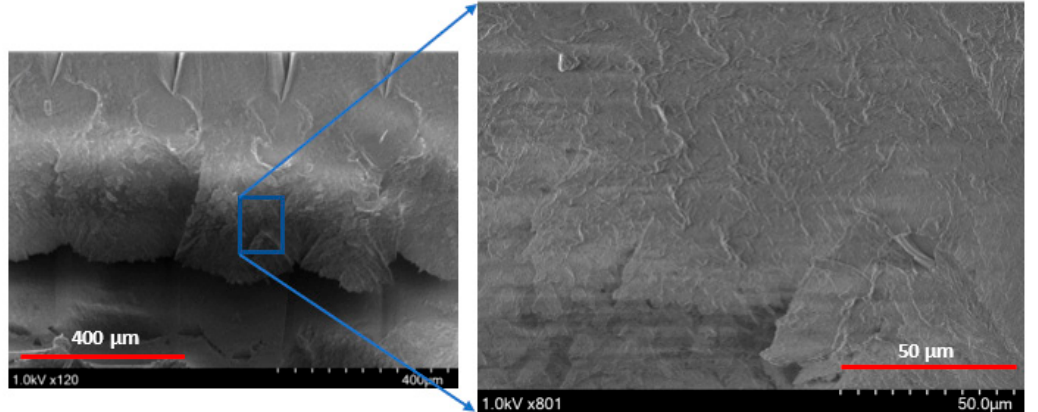
Figure 15. Scanning electron microscope snapshot of the shear zone in the +45°/ − 45° orientation with a 13.39° shear angle, (left) zoomed out. Close up of the shear zone (right).